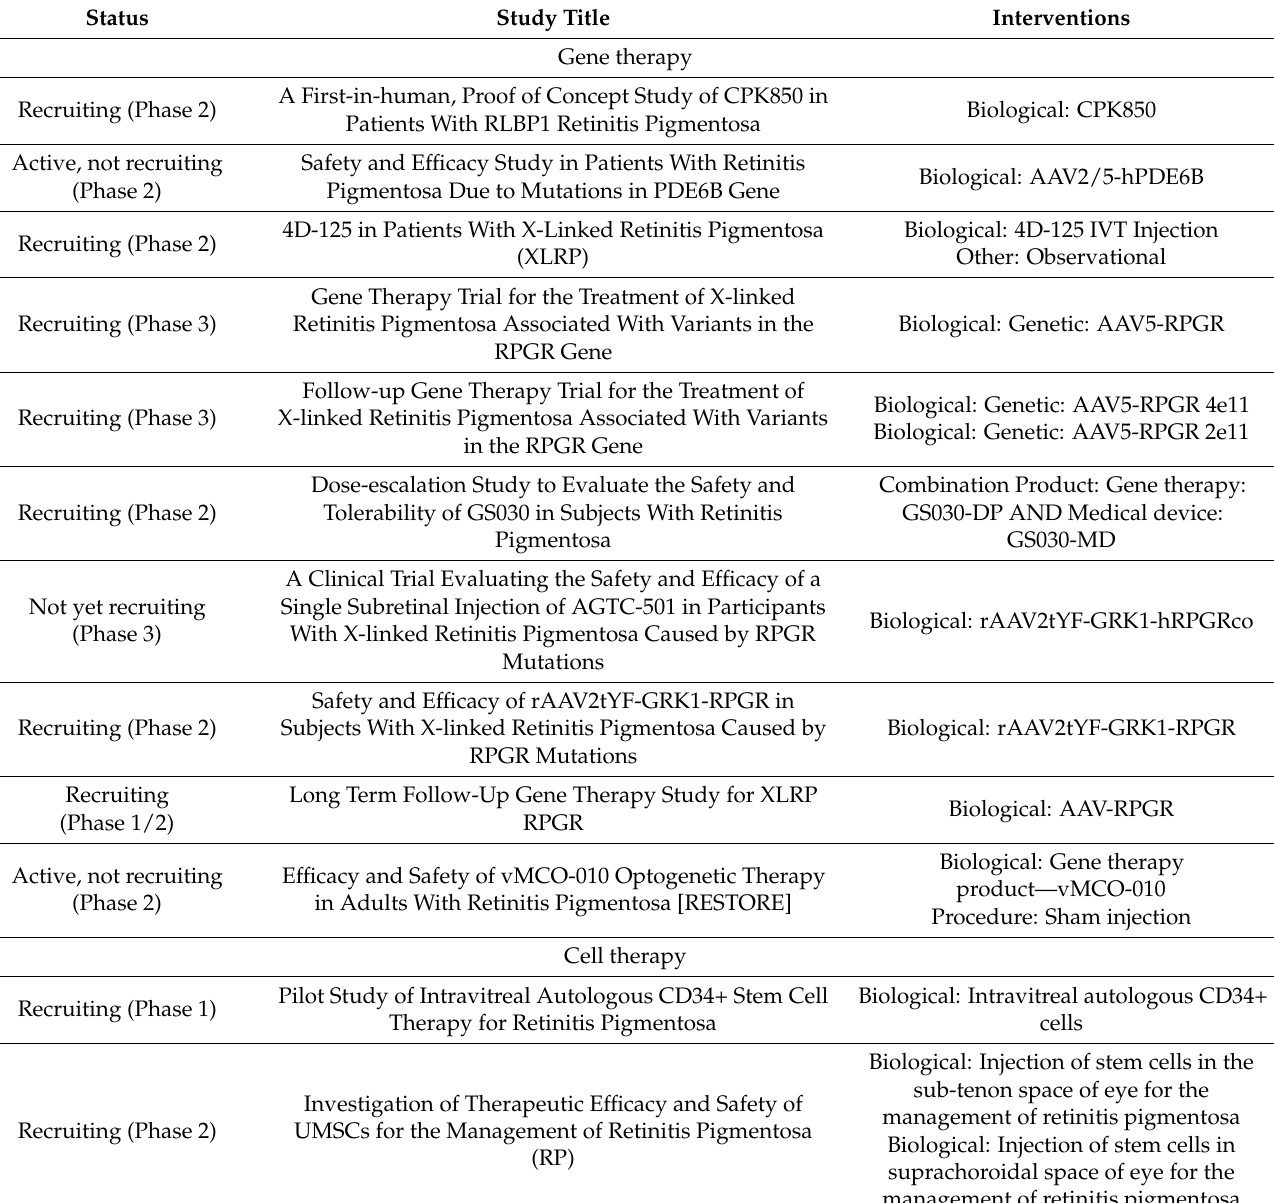
Table 3. Ongoing clinical trials of potential gene and cell therapies for retinitis pigmentosa